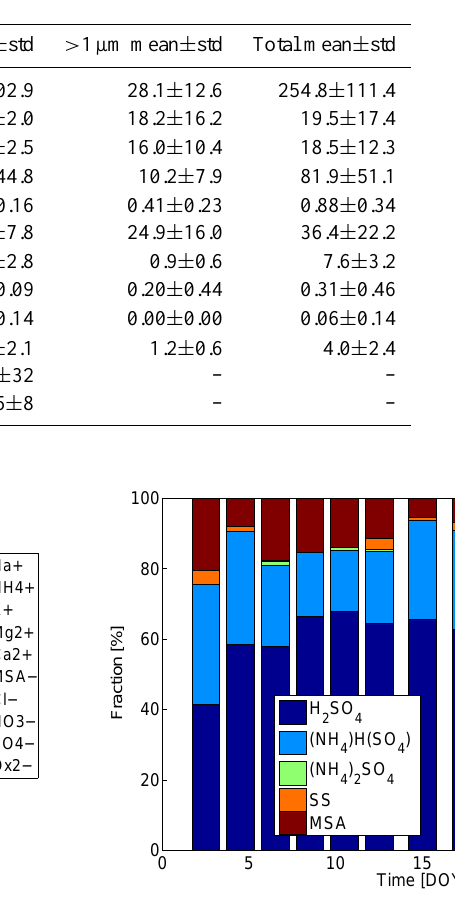
Table 6. Average concentrations [ngm − 3 ] and standard deviations of SDI measured ions and organic carbon and water-soluble organic carbon at ranges: < 1µm, > 1µm and total in 12 collected samples. OC and WSOC were only measured below 1µm and backup filter masses are substracted.